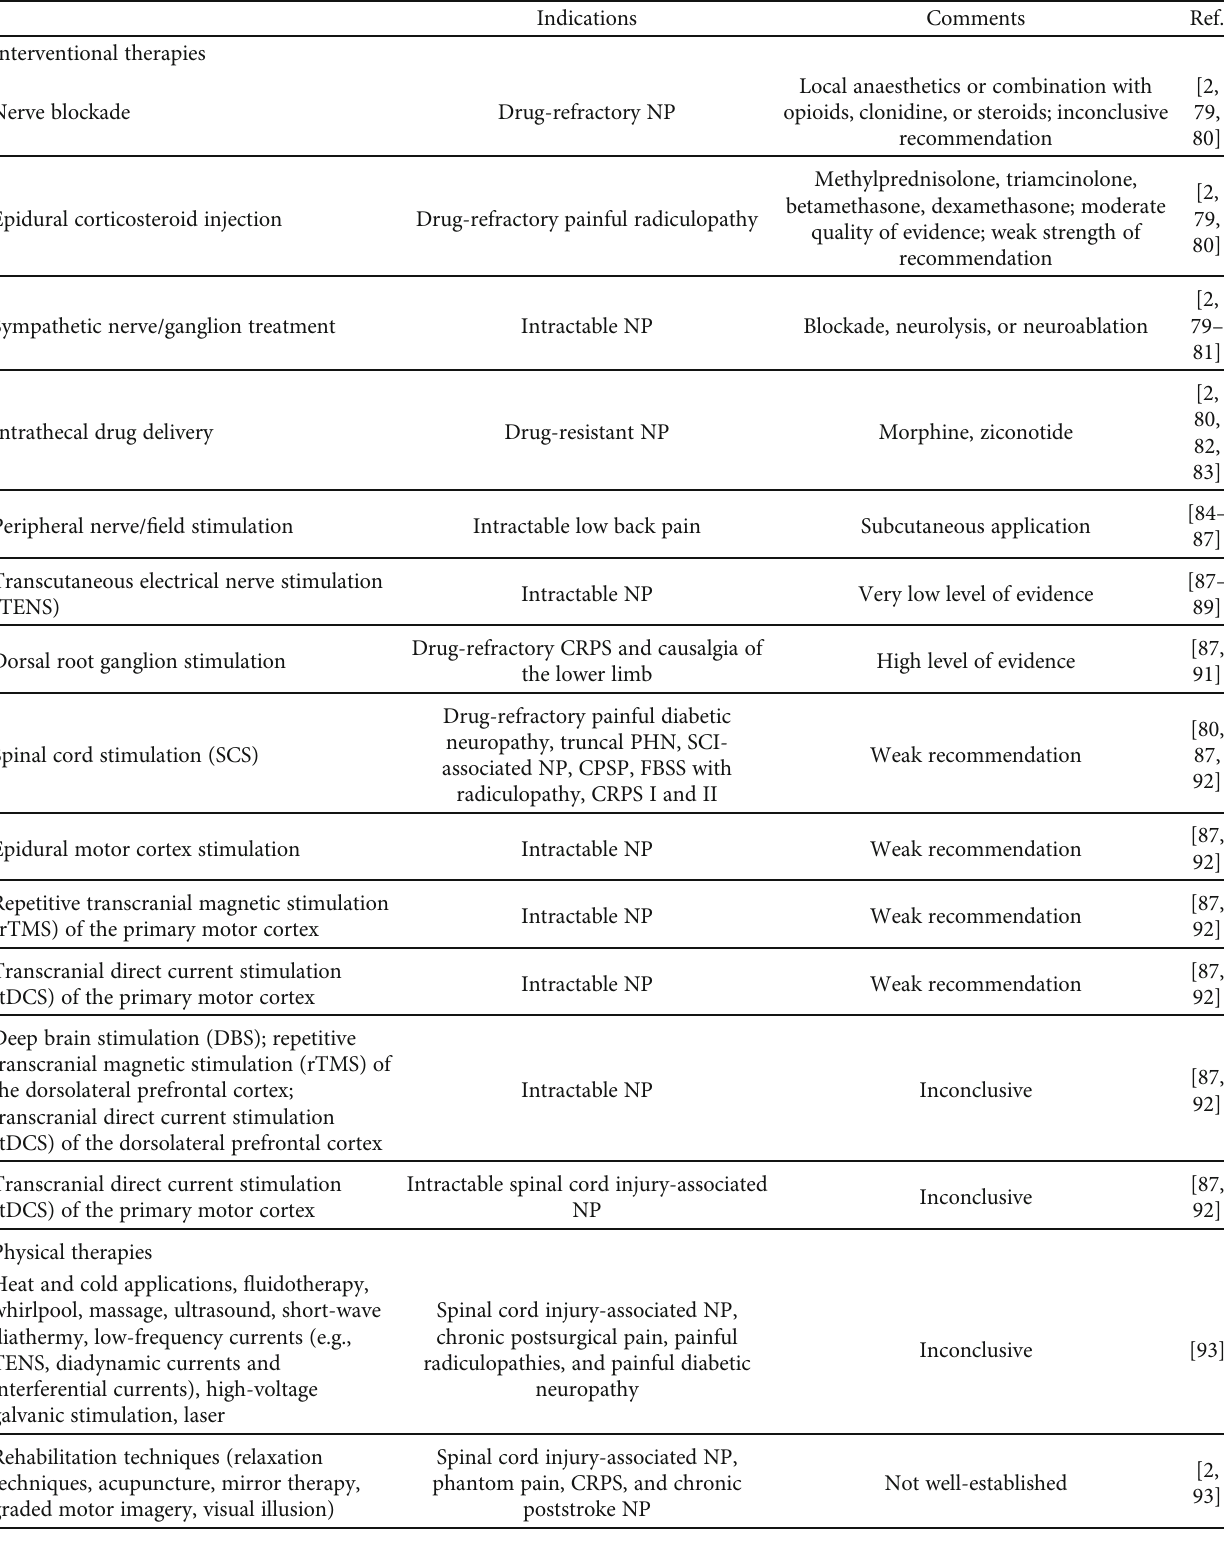
Table 4: Nonpharmacological therapeutic options for neuropathic